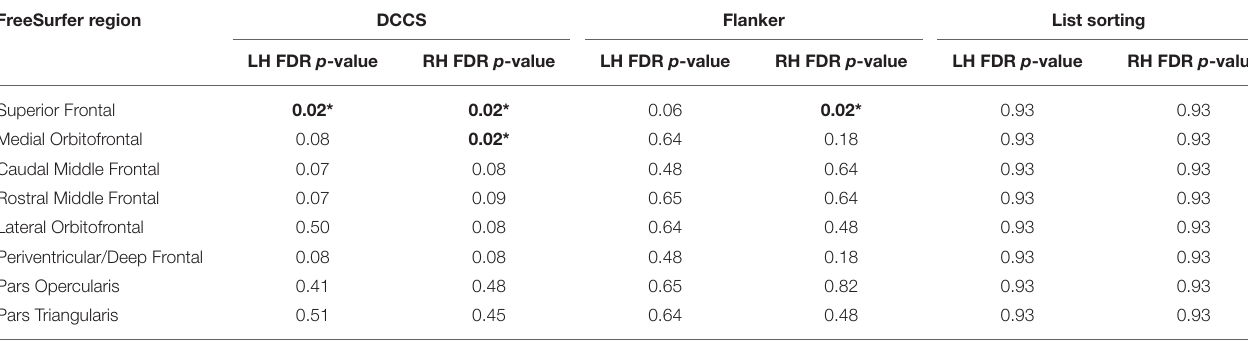
TABLE 4 | Results for left and right hemisphere WMH in NIH toolbox executive functioning. FreeSurfer